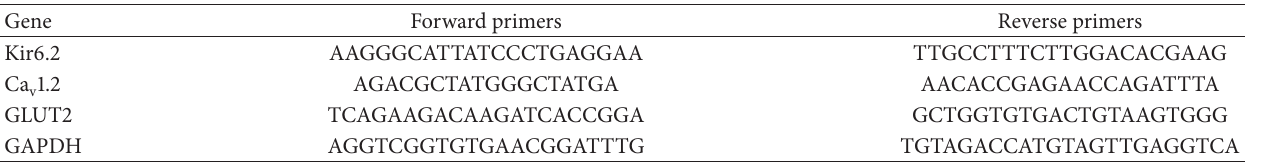
Figure 7: Effects of simvastatin on 𝐼 and current density in MIN6 cells. (a) 𝐼 current of control group cells at 10mV, (b) 𝐼 Ca-L Ca-L current of cells with application of 5 𝜇 mol/L simvastatin at 10mV, (d) 𝐼 of cells with application of 2 𝜇 mol/L simvastatin at 10mV, (c) 𝐼 Ca-L current of cells with application of 10 𝜇 mol/L simvastatin at 10mV, (e) current density-voltage ( J - V ) curves of four groups, and (f) the 𝐼 current densities of cells with application of different concentrations of simvastatin at 10mV voltage. Table 1: Real-time PCR primers.